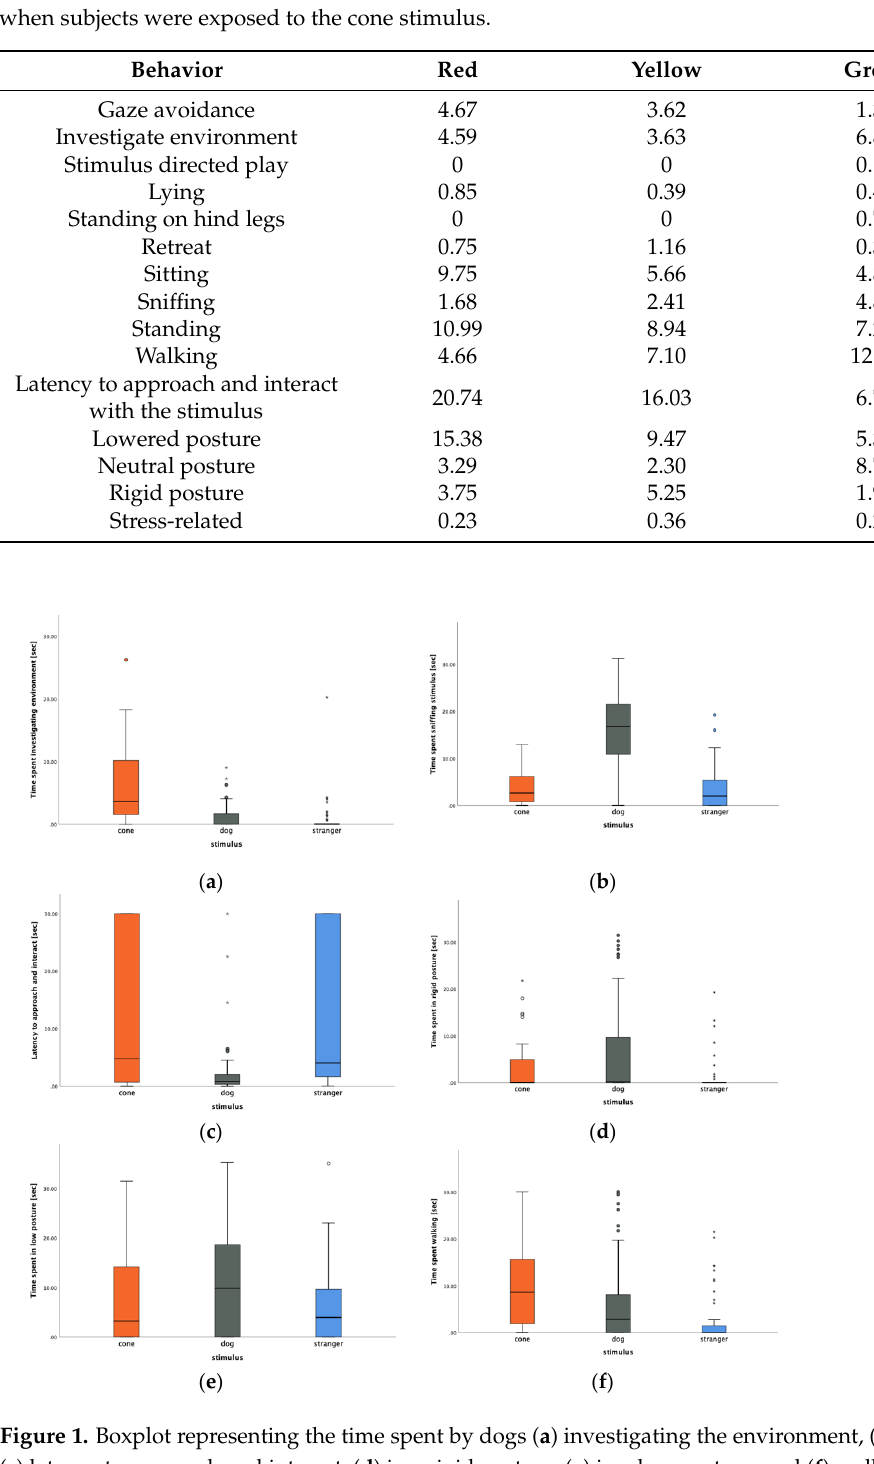
Figure 1. Boxplot representing the time spent by dogs ( a ) investigating the environment, ( b ) sniffing, ( c ) latency to approach and interact, ( d ) in a rigid posture, ( e ) in a low posture, and ( f ) walking, when presented with three different stimuli: a traffic cone (cone), a dog statue (dog), and an unfamiliar person approaching (stranger). Values represented are: medians (bar within the box), upper and lower quartiles (borders of box), lowest and highest cases within 1.5 times the IQR (bottom and top whiskers) and outliers (circles and asterisks). Further analysis revealed no significant differences in behavioral responses for all stimuli between male and female subjects. Pen size was found to influence a dog’s posi- tion within the pen: dogs in larger pens (i.e., more square meters of surface) spent less time in the back of pen compared to dogs in smaller pens ( t = −2.08, p = 0.042). All other associations were non-significant.